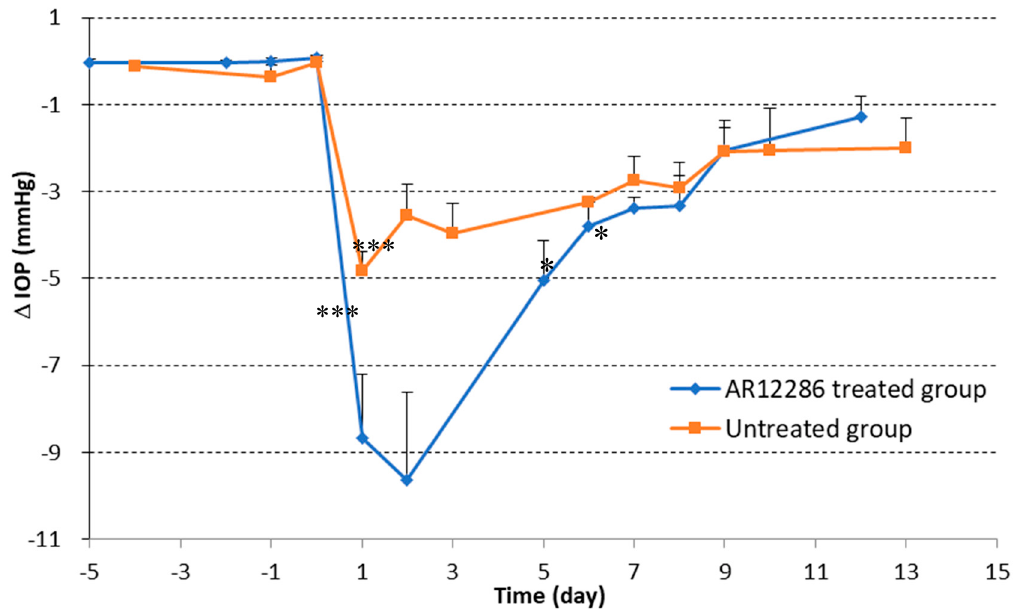
Figure 1. Effect of AR12286 on intraocular pressure (IOP) maintenance in rabbit models of trabeculectomy. IOP changes over entire experimental period are illustrated. Compared with IOP from the same rabbits prior to surgery (baseline), IOP levels in both groups were at lower levels throughout the entire experiment period. ∆ IOP is the difference between IOP of surgical and nonsurgical eyes. ∆ IOP in AR12286 group rabbits (trabeculectomy with AR12286 treatment) exhibited significantly lower level at Days 1 ( p < 0.001), 2 ( p < 0.001), 6 ( p < 0.05), and 7 to 8 ( p < 0.05) than IOP from control group (trabeculectomy only). Asterisks indicate significantly different responses (*, p < 0.05; ; ***, p <